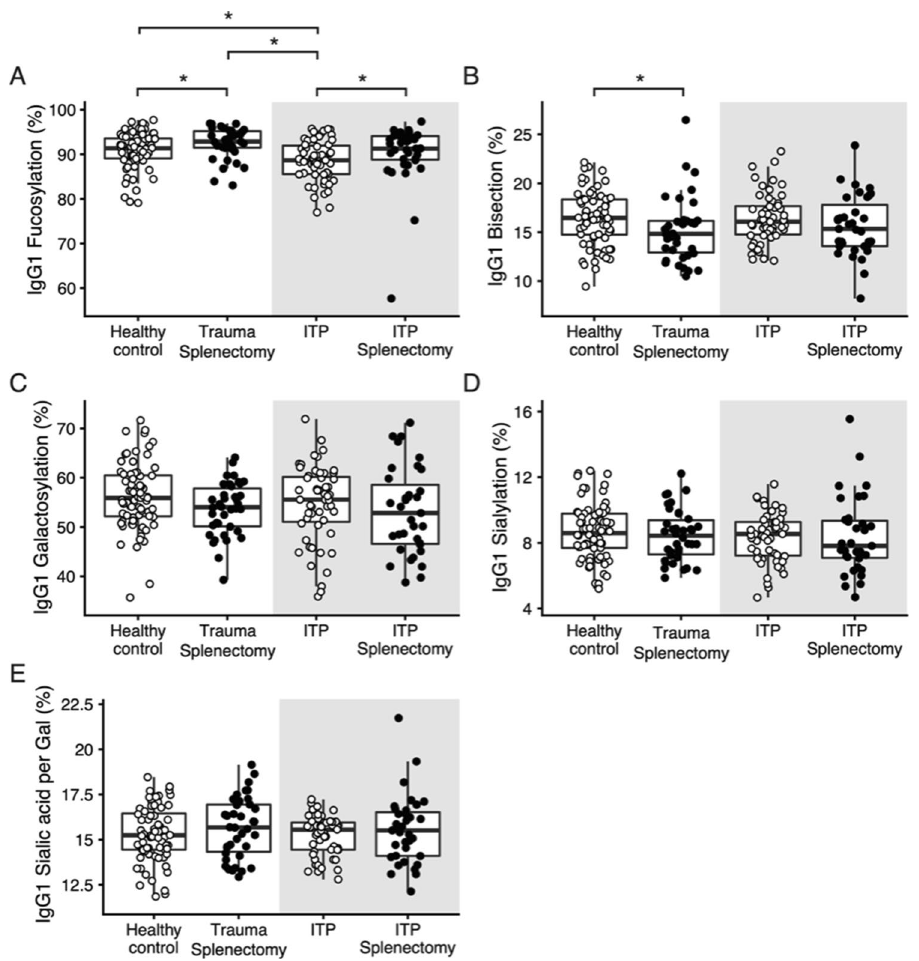
Figure 2. Effect of splenectomy on IgG1-Fc glycosylation in healthy individuals and ITP patients. Data are shown for healthy individuals with (Healthy Control, n = 38) or without splenectomy (Trauma Splenectomy, n = 76) and ITP patients with (ITP Splenectomy, n = 35) or without splenectomy (ITP, n = 57), matched for age and sex. Compared to the respective controls, IgG1-Fc fucosylation was higher in splenectomized and otherwise healthy individuals ( P = 0.026; Wilcoxon-rank sum test), as well as in splenectomized ITP patients ( P = 0.017; Wilcoxon-rank sum test). Regarding IgG1-Fc bisection, otherwise healthy individuals showed lower levels ( P = 0.008; Wilcoxon-rank sum test), whereas in splenectomized ITP patients this difference was less prominent and did not result in a finding. ITP patients have reduced IgG1-Fc fucosylation compared to healthy controls ( P = 0.017; Kruskal–Wallis rank sum test followed by a post-hoc Nemenyi test for pairwise comparison). All other glycosylation features were not significantly different between the groups. * P -values are given for a Wilcoxon-rank sum test, P -values < 0.05; ns, not